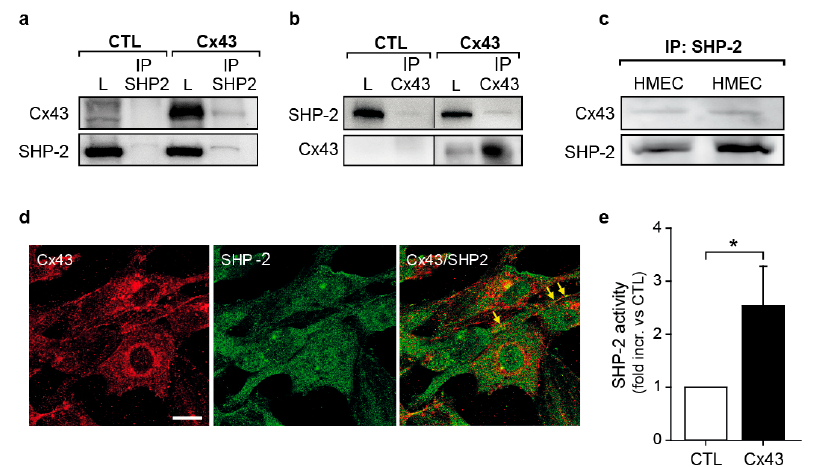
Figure 3. Interaction of Cx43 and SHP-2 induces SHP-2 phosphatase activity. ( a ) Upon immunopre- cipitation (IP) of SHP-2 from HeLa cells expressing only Cx43, Cx43 was co-immunoprecipitated.